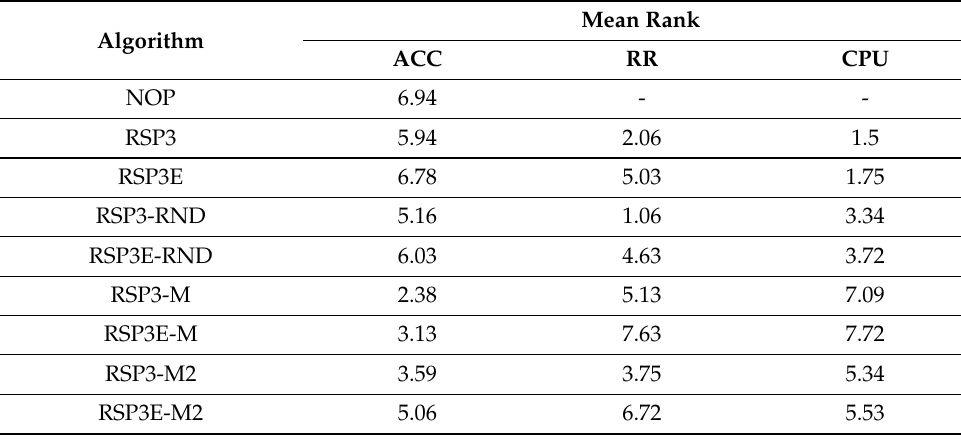
Table 5. Results of Friedman test on ACC, RR and CPU measurements.